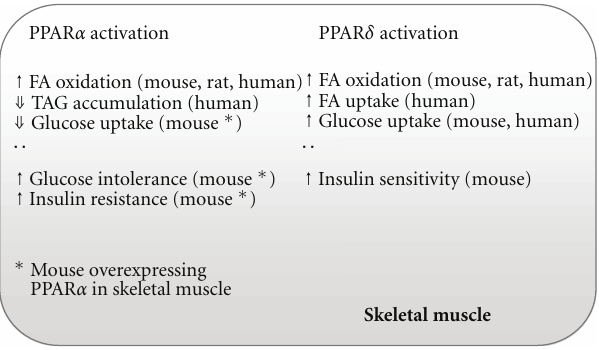
Figure 2: Examples of metabolic e ff ects of PPAR α or PPAR δ activation in skeletal muscle. FA, fatty acid; TAG, triacylglycerol. For references, see the